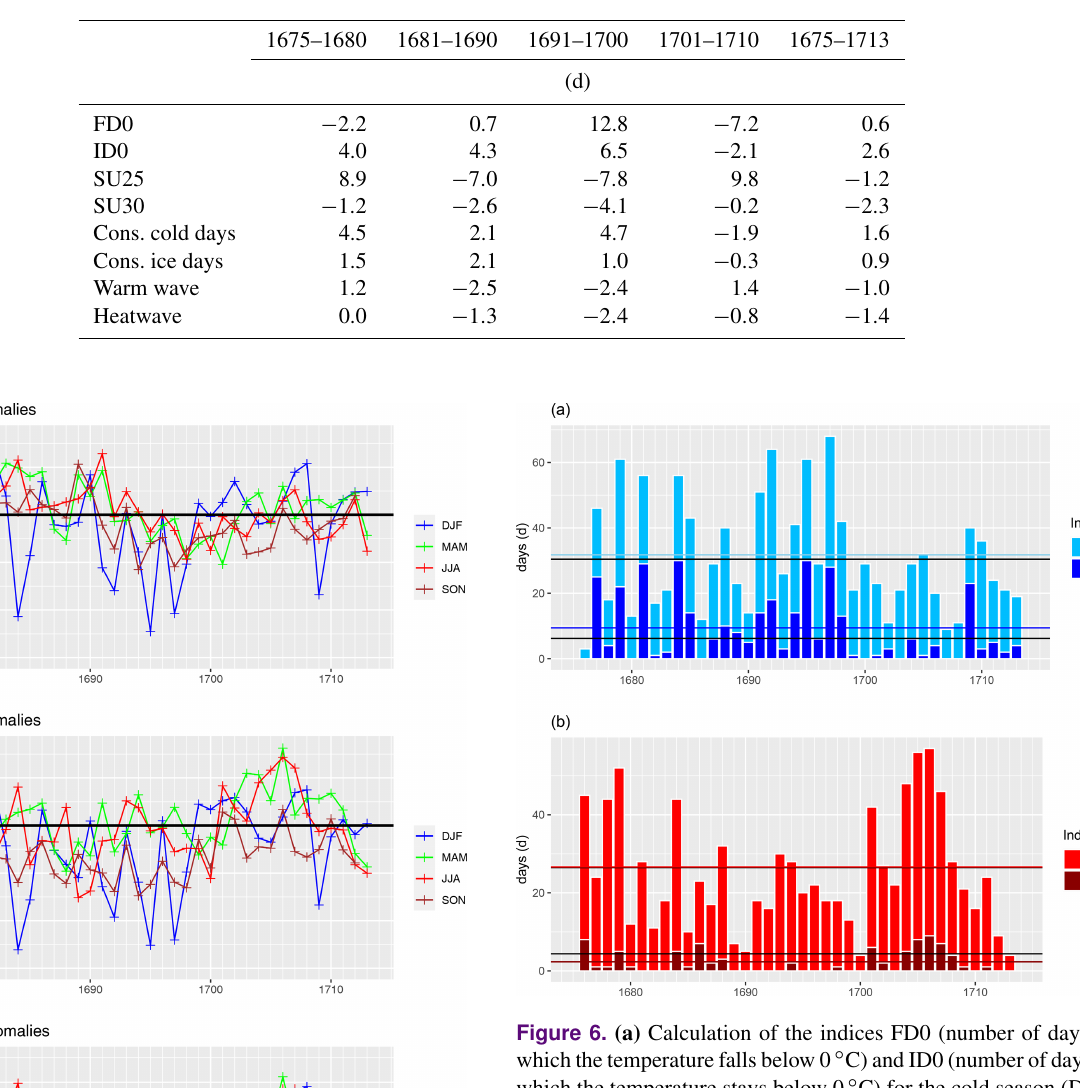
Table 3. Anomalies of FD0, ID0, cons. cold days, and cons. ice days for the season DJF and SU25, SU30, warm waves, and heatwaves for the season JJA with respect to the reference period (E-OBS: 1961–1990).